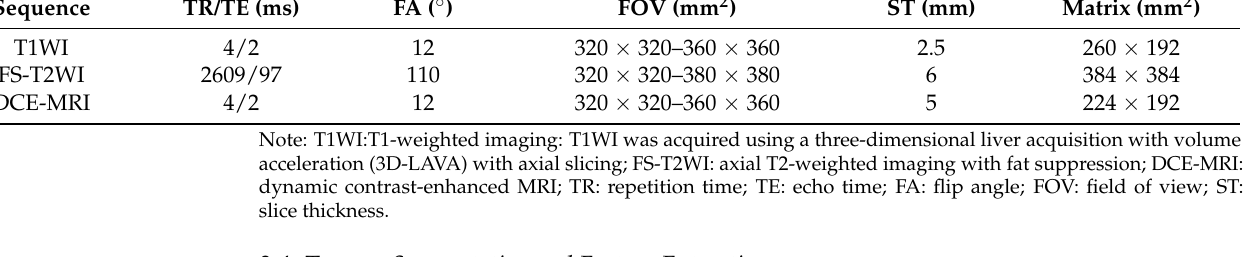
Table 1. MRI sequences and their related parameters.